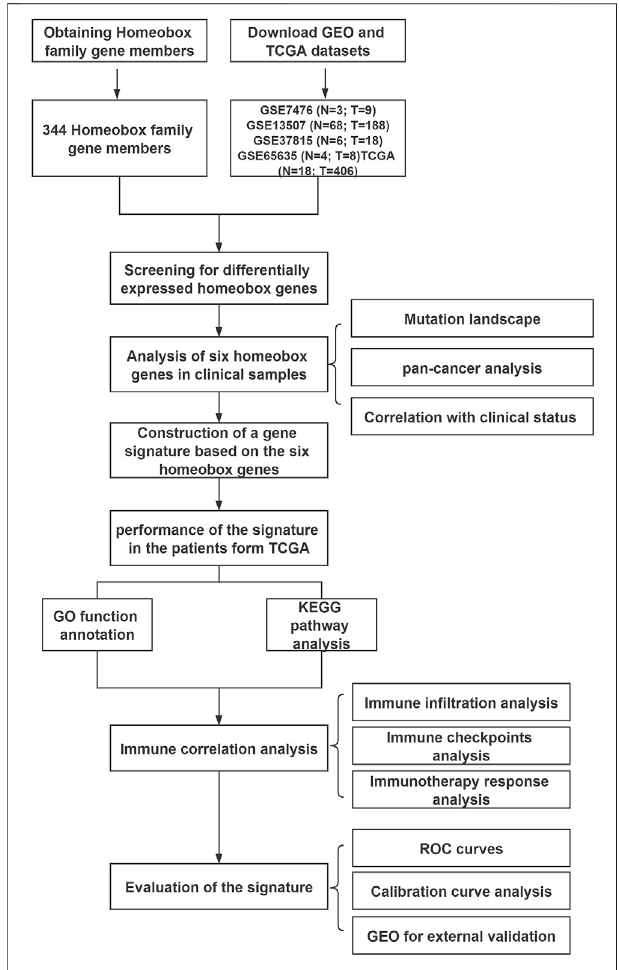
FIGURE 1 | Flow chart showing the design of the study, with GSE7476 ( N (cid:1) 3; T (cid:1) 9), GSE13507 ( N (cid:1) 68; T (cid:1) 188), GSE37815 ( N (cid:1) 6; T (cid:1) 18), GSE65635 ( N (cid:1) 4; T (cid:1) 8), and TCGA ( N (cid:1) 18; T (cid:1) 406)